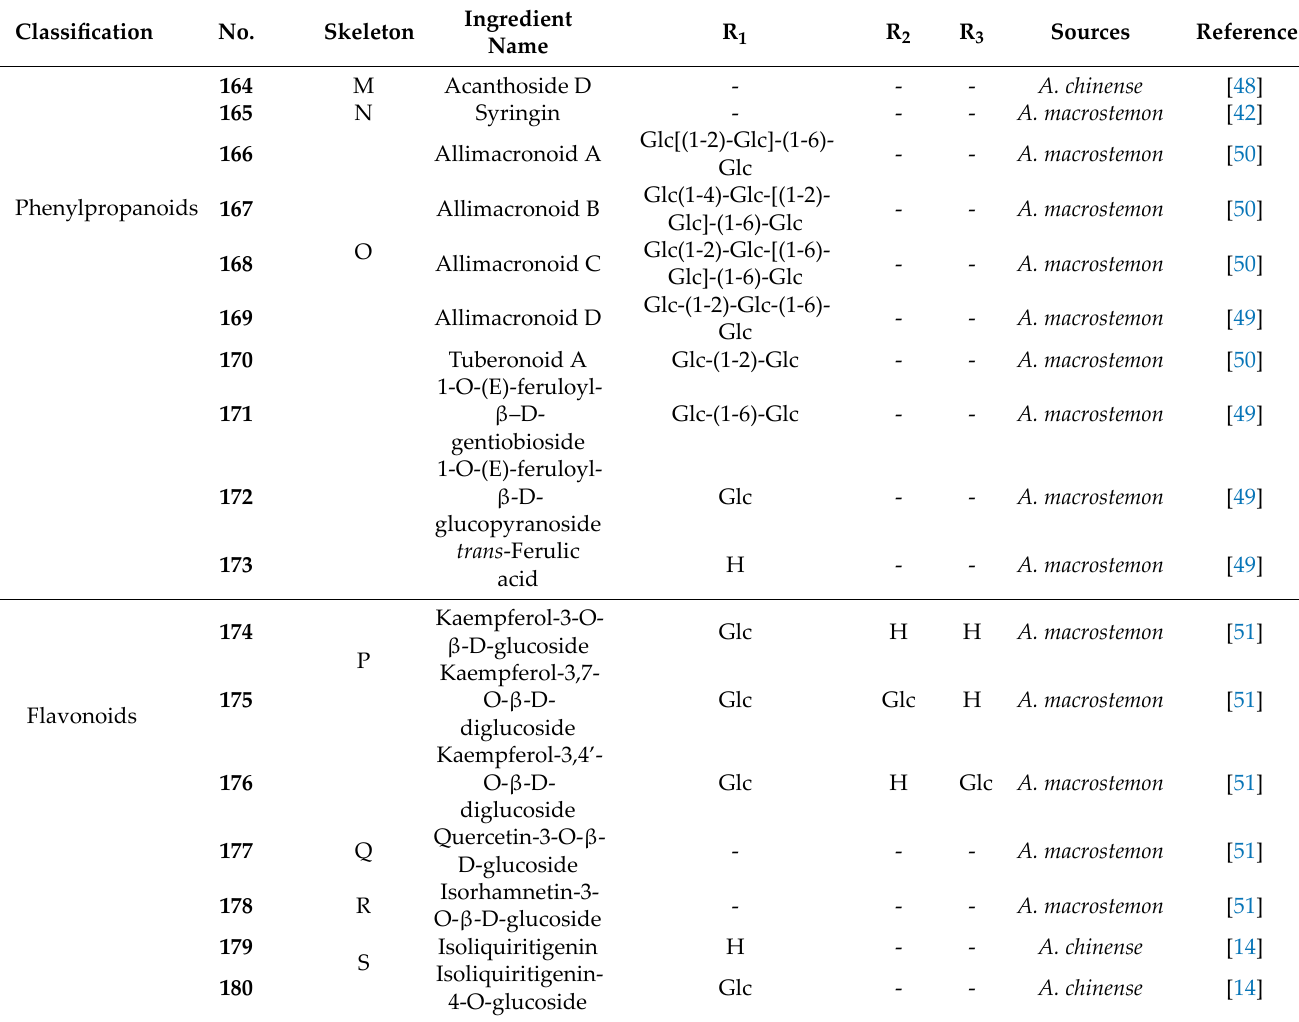
Table 7. List of phenylpropanoid and flavonoid components isolated from